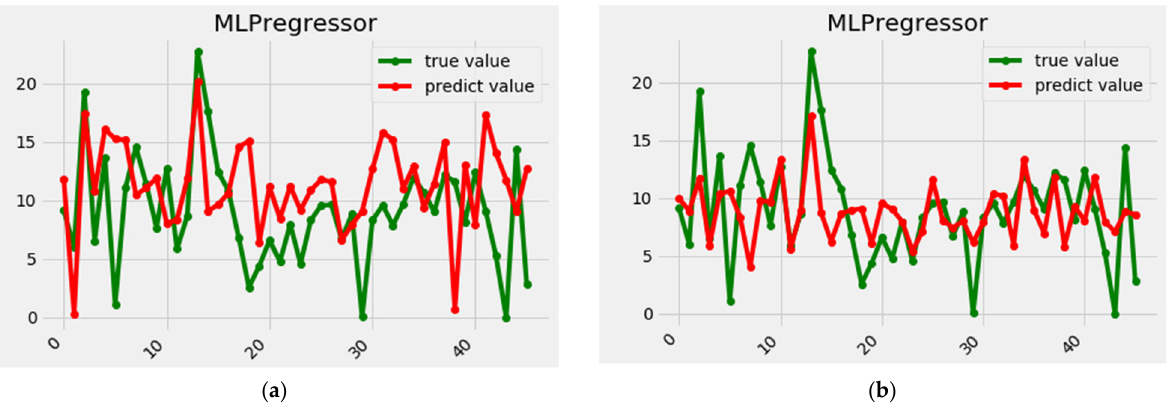
Figure 14. The fitted results of two InSAR methods with multilayer perceptron. The left one ( a ) represents the comparison of interference difference tree heights fitted using multilayer perceptron, and the right one ( b ) shows the comparison of coherent amplitude tree heights fitted using multi-layer perceptron.